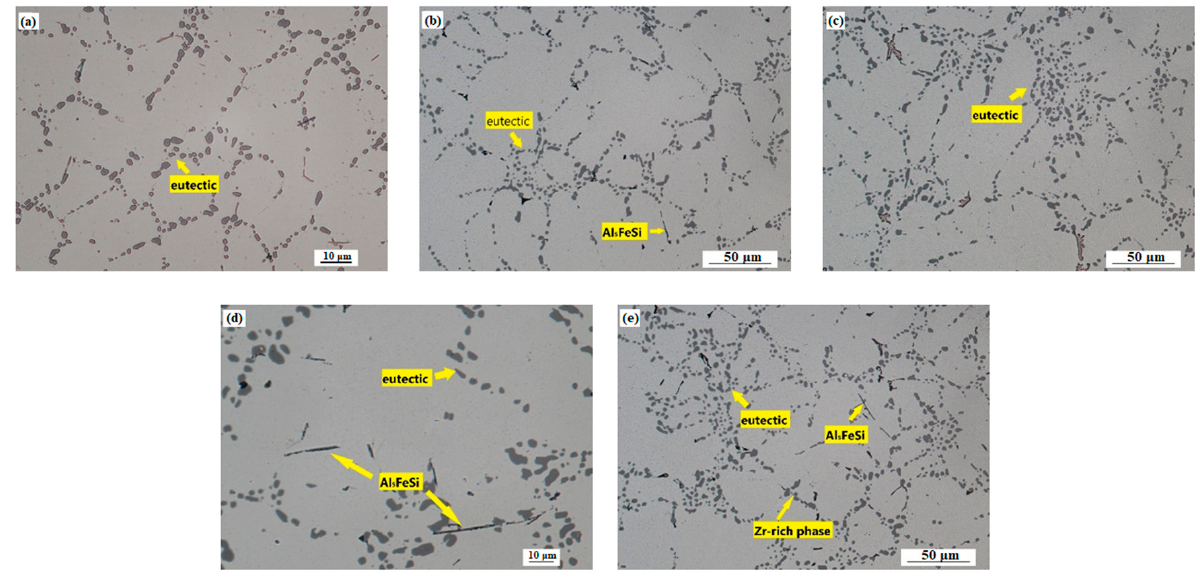
Figure 12. Microstructure of experimental alloys AlSi5Cu2MgZrX (T7, H 2 SO 4 etch.): addition of ( a ) 0 wt. % Zr; ( b ) 0.05 wt. % Zr; ( c ) 0.10 wt. % Zr; ( d ) 0.15 wt. % Zr; ( e ) 0.20 wt. % Zr.